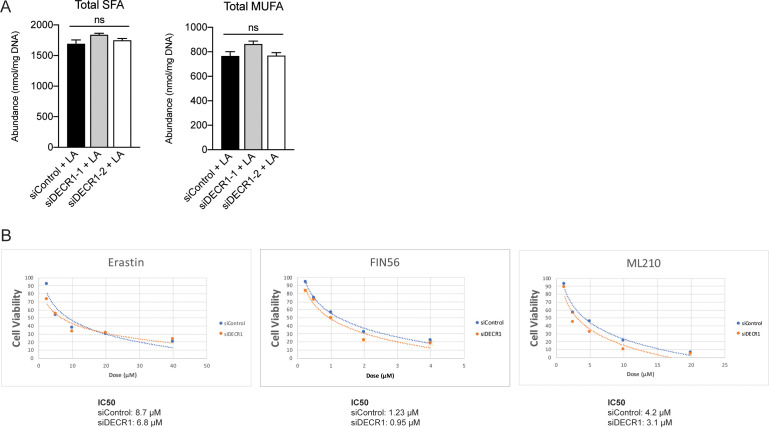
Depletion of DECR1 sensitizes prostate cancer cells to ferroptosis inducing agents.(A) Abundance of total SFA and (B) MUFA species in phospholipids from control and DECR1 knockdown cells supplemented with linoleic acid (LA). (C) Abundance of total SFAs (left) and MUFAs (right) in Control and DECR1 knockdown cells supplemented with LA. (D) IC50 values of ferroptosis inducers were determined in Control and DECR1 knockdown cells. Statistical analysis was performed using two-tailed Student’s t-test: *p<0.05, **p<0.01 and ***p<0.001.